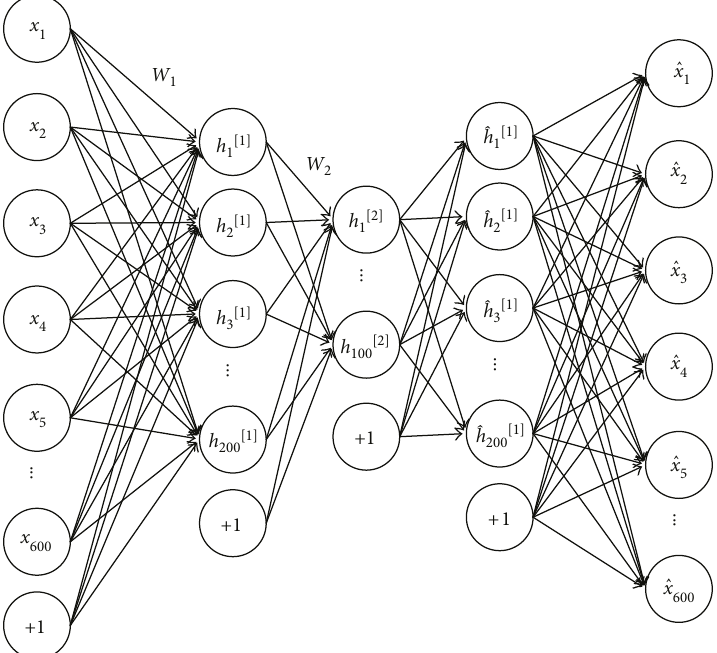
Figure 2: Schematic illustration of the stacked